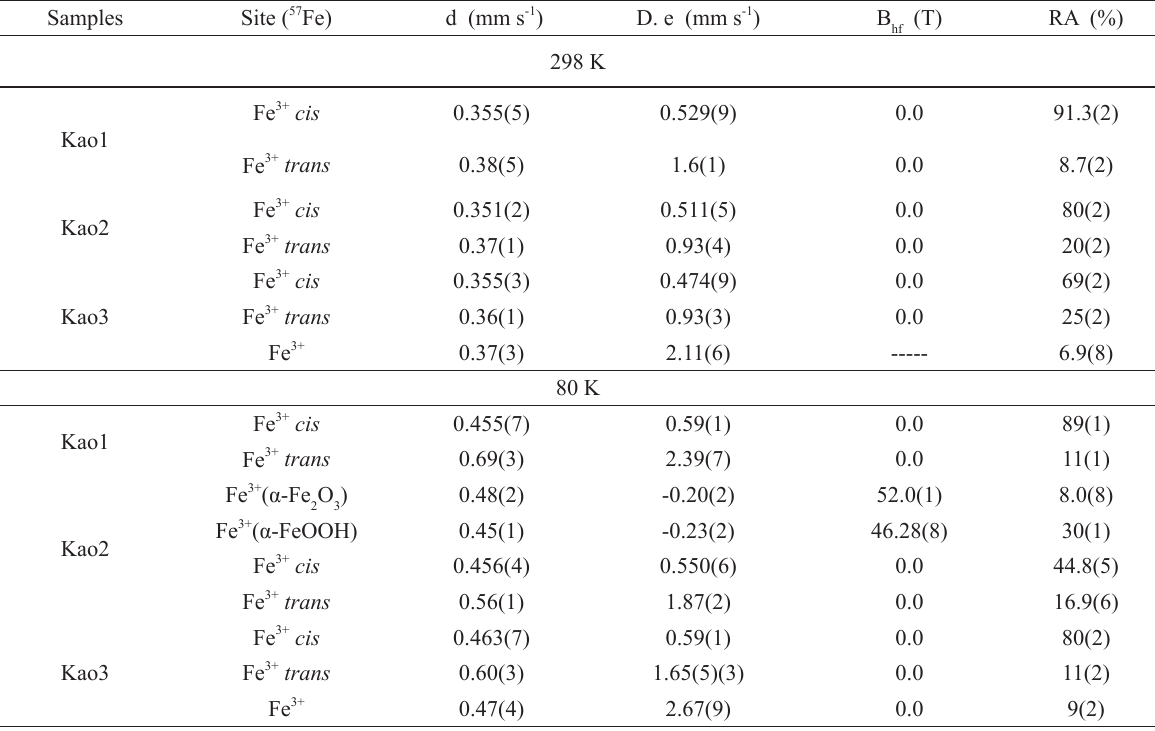
Mössbauer parameters at 298 and